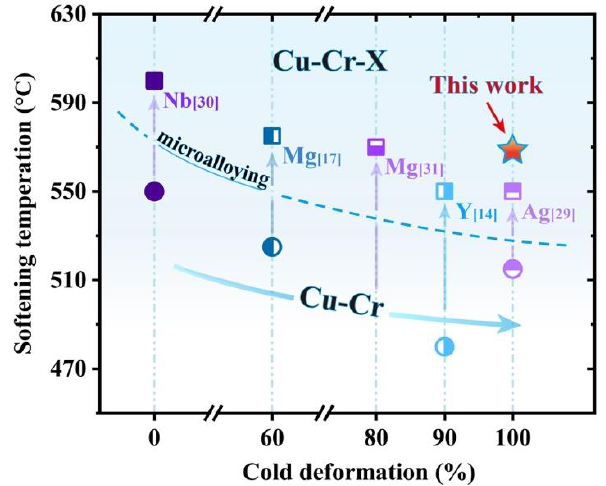
Figure 7. Relationship between softening temperature and cold deformation of Cu-Cr-(X) alloys.